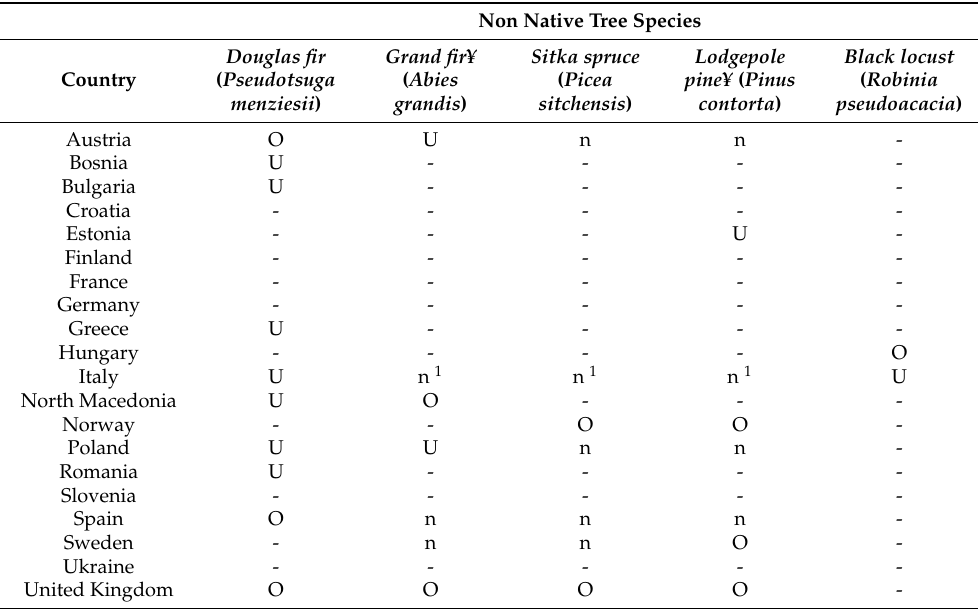
Figure 2. Forest reproductive material (FRM) transfer guidelines for non-native tree species in Europe. The flow chart presents different options of origin, basis for the guidelines, base populations and categories of recommended basic material. Table 1. Availability and type of provenance recommendations in different European countries based on the questionnaire